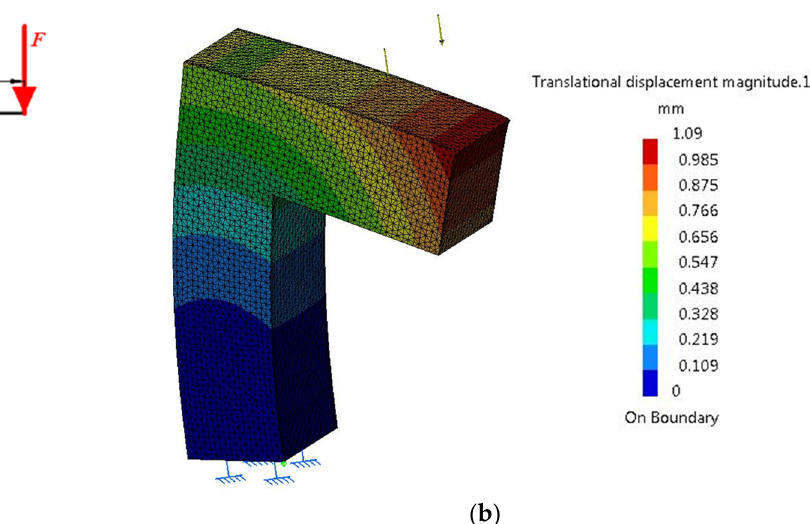
Figure 4. Compression and bending deformation of a pole with arm in the console. Schematic representation ( a ) and state of deformations ( b ).